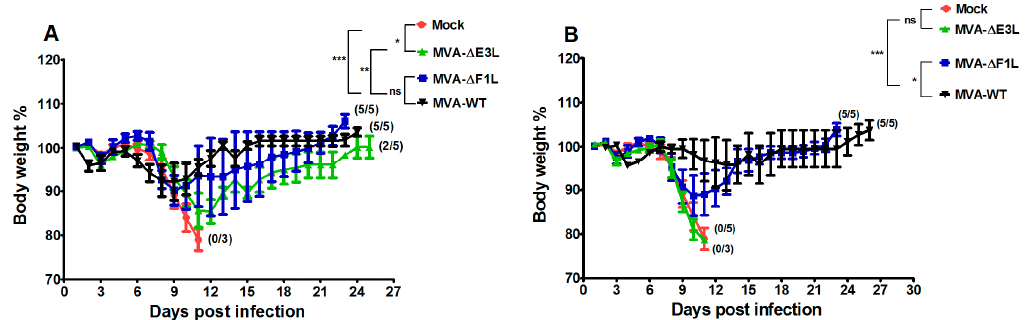
Figure 2. Protective capacity of MVA vaccination against lethal mousepox virus infections. C57BL/6 mice were challenged with 2000 plaque forming units (pfu) ECTV 21 days after immunization with MVA vaccine at a dose of 10 6 pfu ( A ) or a dose of 10 5 pfu ( B ) or PBS (mock vaccinated animals, used as controls). In all experiments, weight loss of individual mice was monitored daily (three to five per group). Error bars indicate standard errors of the means (SEMs), and the numbers of surviving/total animals are given in parentheses. * p < 0.05; ** p < 0.01; *** p < 0.001. Data are representative of two or three experiments.